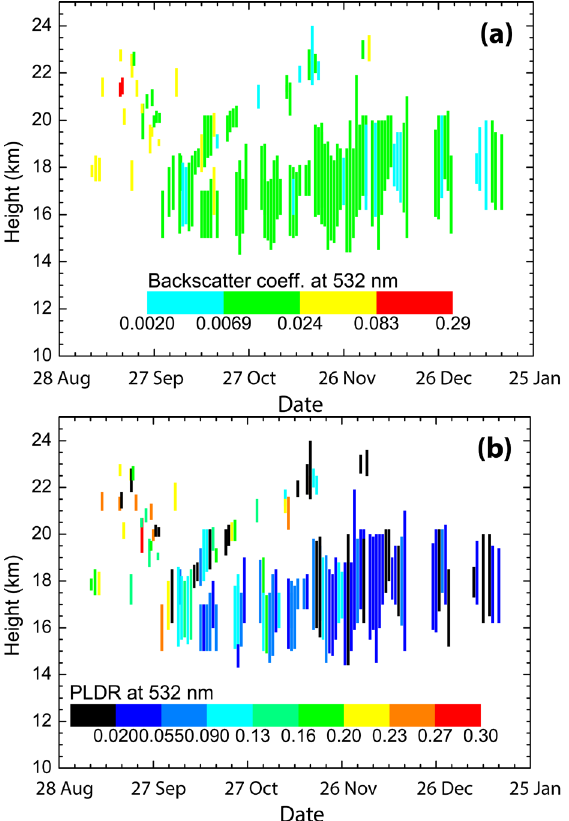
Figure 3 The stratospheric smoke layer over Cyprus between August 2017 and January 2018. The vertical extend is marked with the bars, color coded with the particle backscatter coefficient (a) on a logarithmic scale and the particle linear depolarization ratio at 532 nm (b) on a linear